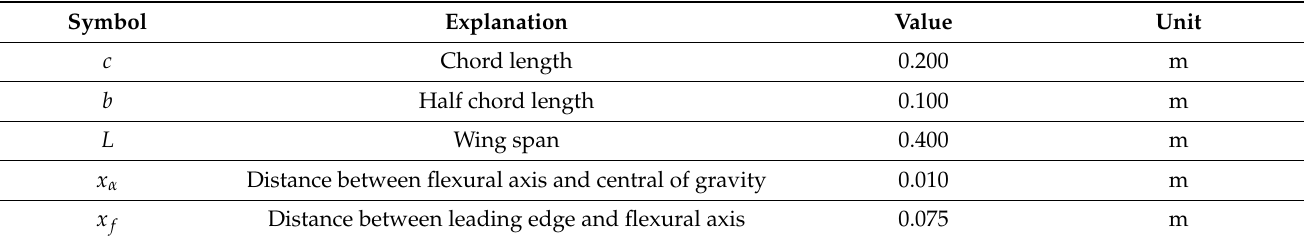
Table A1. Parameters of the wing